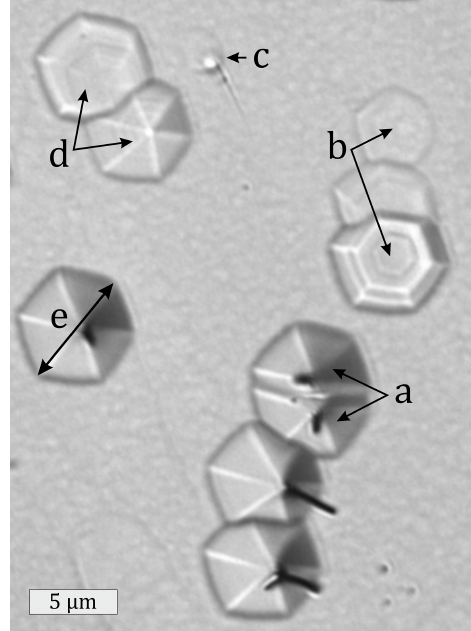
Figure 2. Loss and gain of tracks in an apatite basal face (B00) etched 20s in 5.5M HNO 3 at 21 ◦ C. (a) Merging tracks; their grow- ing etch pits and shrinking channels will later prevent distinguishing the separate tracks. (b) Shallow tracks; with decreasing depth the dish-shaped etch pits shrink (Stübner et al., 2008), losing contrast until their images dissolve or are no longer recognizable. (c) Track added due to surface etching, characterized by a long, thin etch channel and an undersized etch pit. (d) Two etch pits formed at shal- low tracks with a stepped appearance due to intermittent etching at the track extremities (Wauschkuhn et al., 2015b). (e) Measurement of etch pit